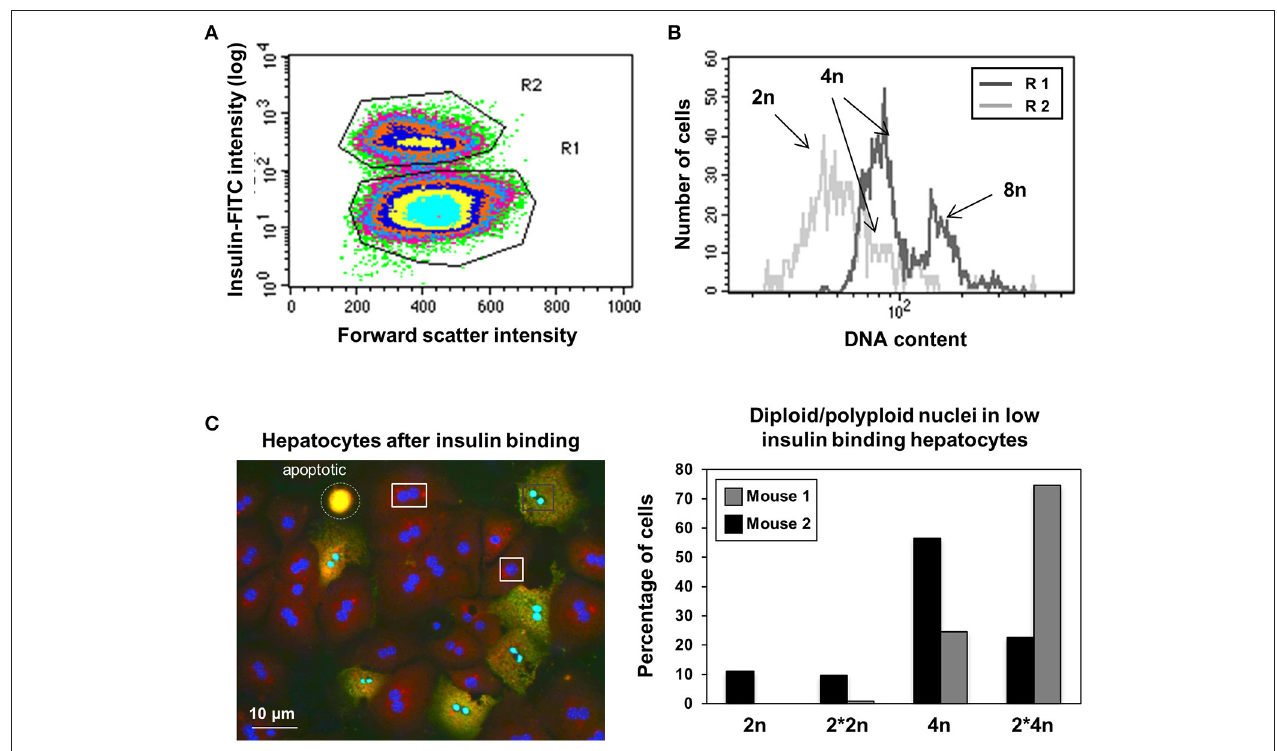
FIGURE 4 | Diploid nuclei containing hepatocytes exhibit higher affinity for insulin. (A) Two types of hepatocytes observed according to their magnitude of insulin-binding exhibit similar cell-size in flow cytometry. (B) Flow cytometry analysis using insulin-FITC show higher insulin binding affinity in 2n cells compared to 8n cells. Again, two types of cells are visible in the 4n DNA containing cells. (C) Low affinity for insulin could mainly be observed in polyploid nuclei. Left: representative microscopy image shows cells with two nuclei in both the high binding and low binding subsets. Right: percentage of 2n and 4n nuclei in insulin low-binding cells as analyzed by HCS. Low binding cells contain polyploidy nuclei, independent of the number of nuclei per cell.